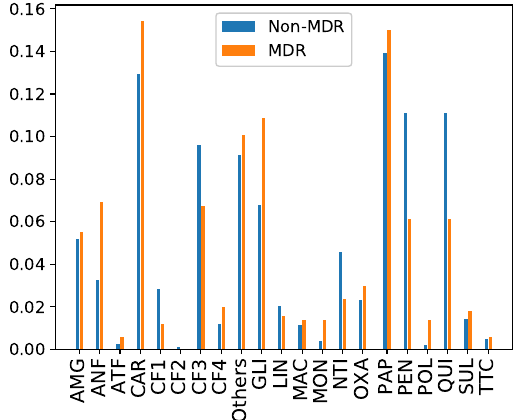
Figure 8. Rate of MDR and non-MDR patient episodes per family of antibiotics administered during the first 48